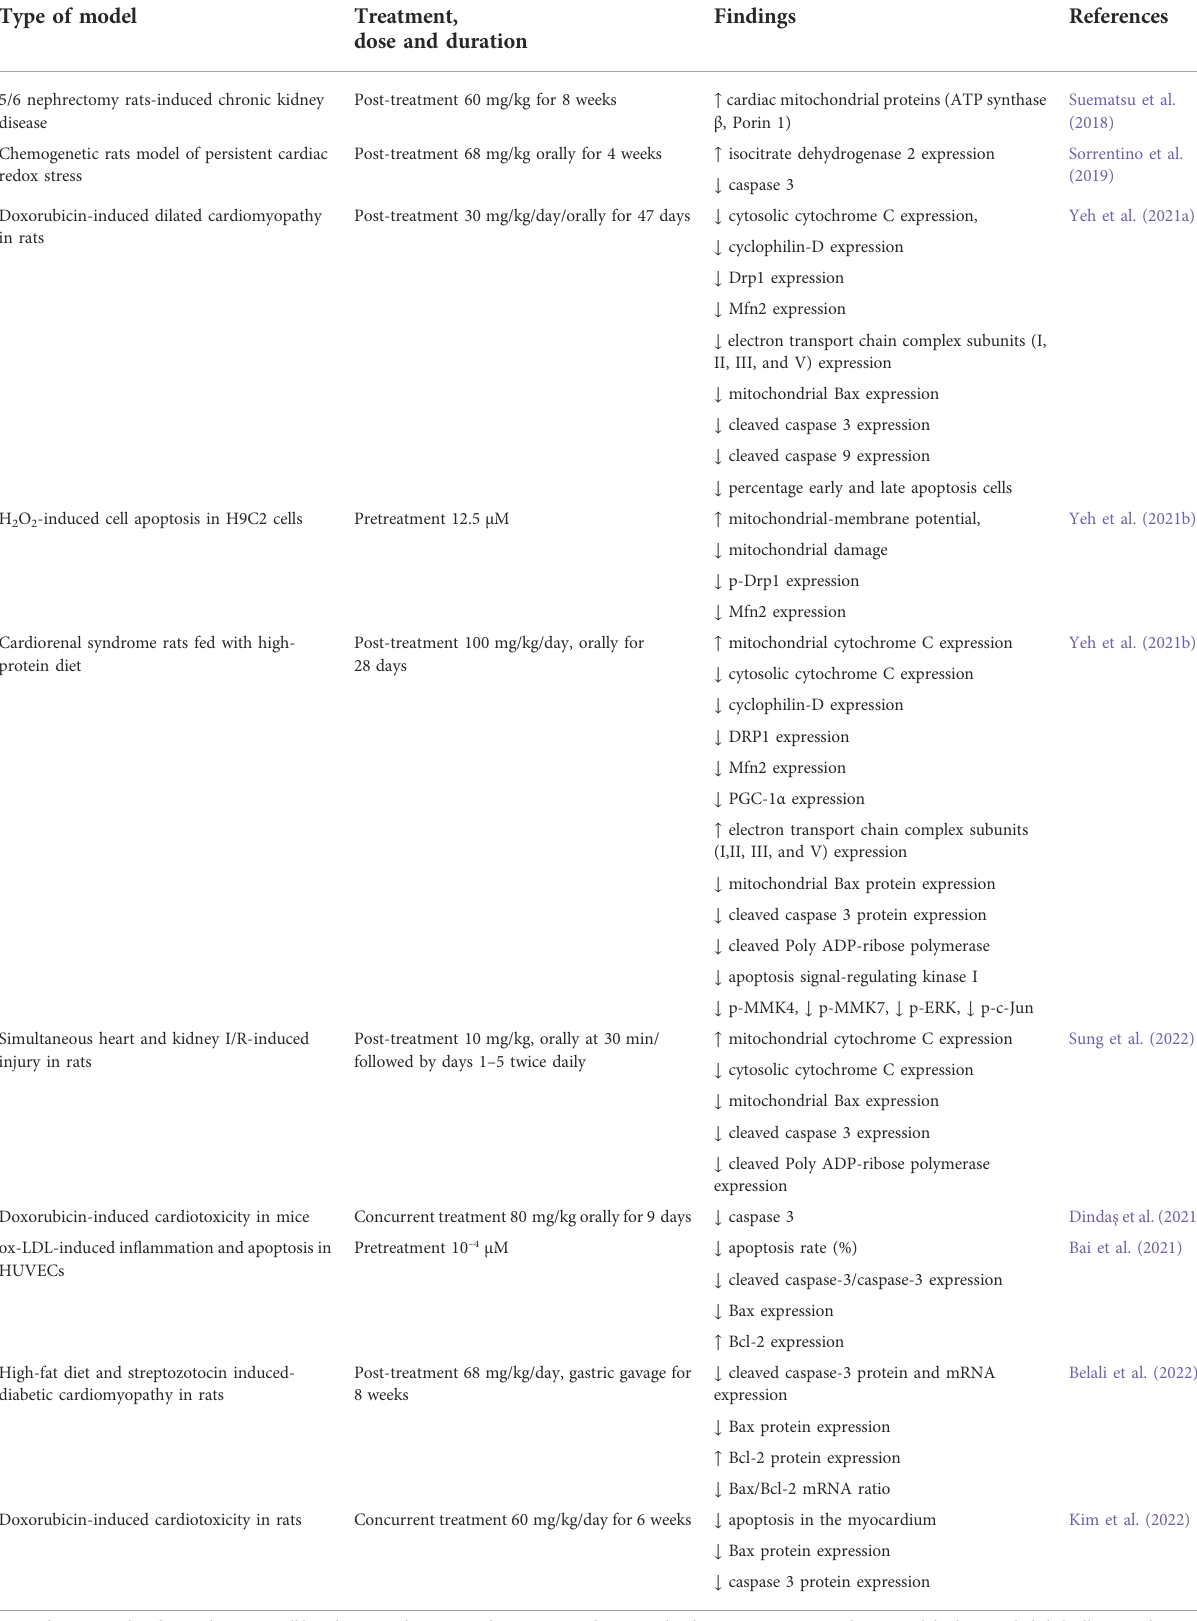
TABLE 6 The effects of sacubitril/valsartan on myocardial mitochondrial function and apoptosis in animal